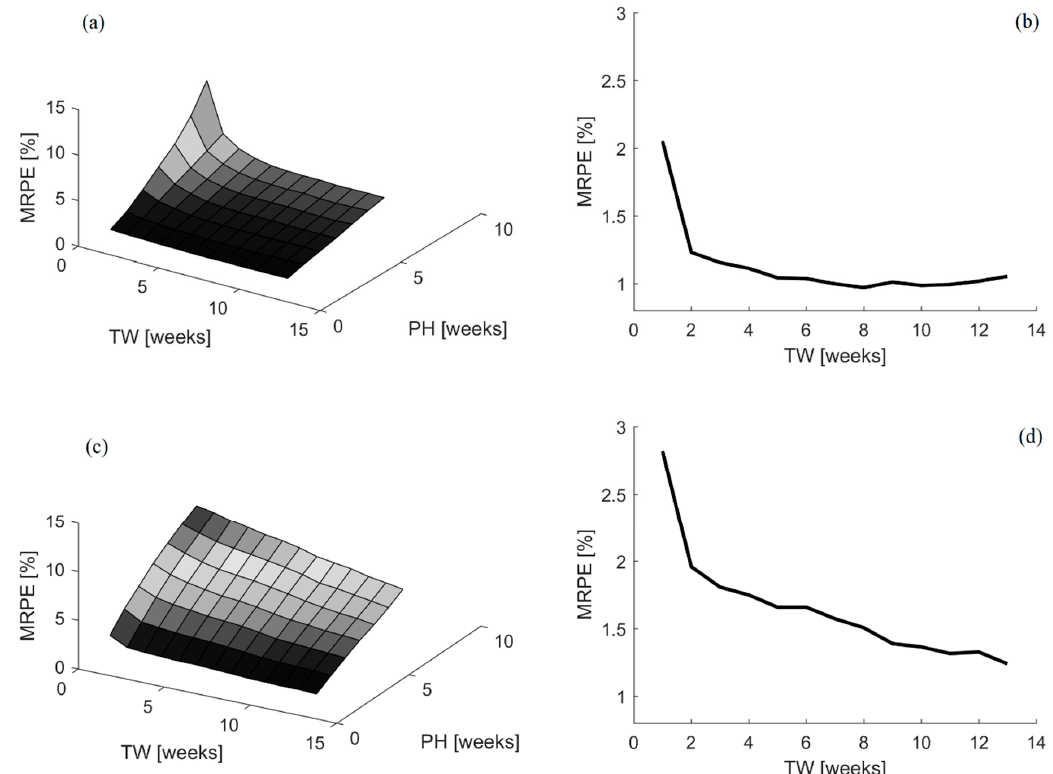
Figure 3. Average mean relative prediction error ( MRPE ) from the 32 test participants in the Minnesota starvation experiment for different combinations of time window ( TW ) and prediction horizon ( PH ) sizes for the DARX ( a ) and DLR ( c ) models. Besides, the MRPE for one-week ahead prediction according to different time window sizes is shown for the DARX ( b ) and DLR ( d ) models.